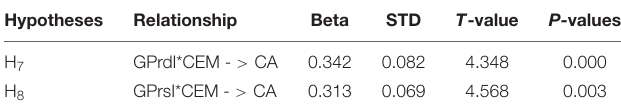
TABLE 6 | Structural model assessment (moderation